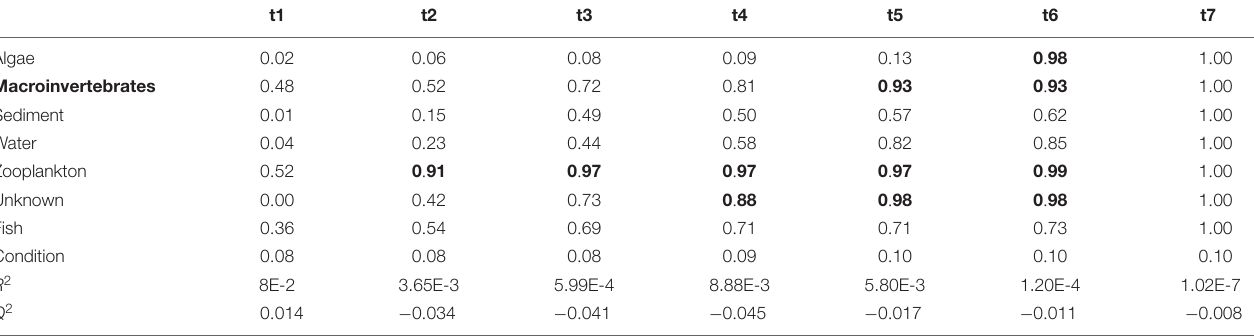
R2Xy value from PLS test shows the relationship between the response and predictor factors. R2Xy values are above 0.8 is bold labeled indicating a more pronounced relationship between fish body condition and dispersal factors. Q 2 and R 2 values from PLS also showed. Q 2 and R 2 values from PLS also showed. t1 to t7 is each of the PLS components.